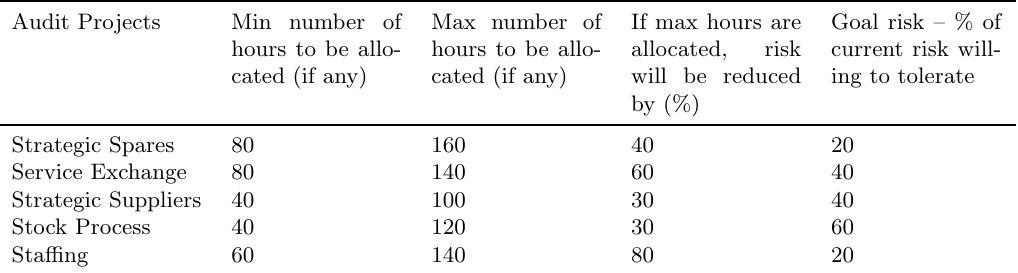
Table 2: Audit projects’ quantitative